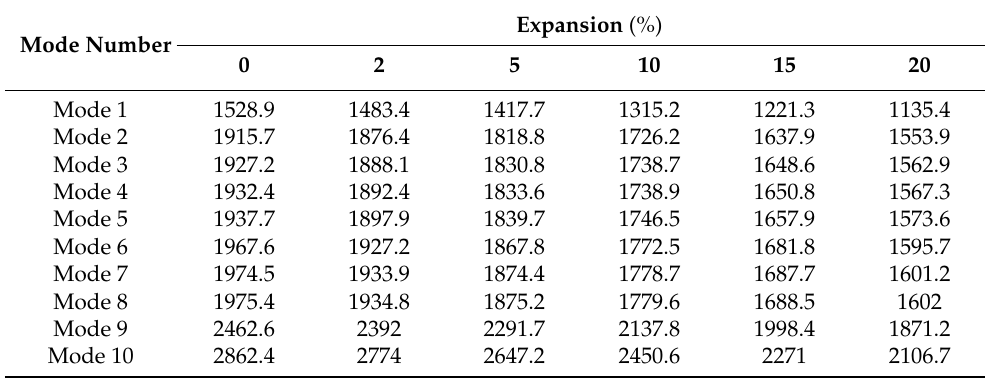
Figure 37. Mode 5 of Timoshenko beams in Topology 1 with hinged ends; spanwise expanded configuration. Table 8. Change of Natural Frequencies, ω ( rad / s ) of Timoshenko beam Analysis with Hinged ends in Topology 1, with spanwise